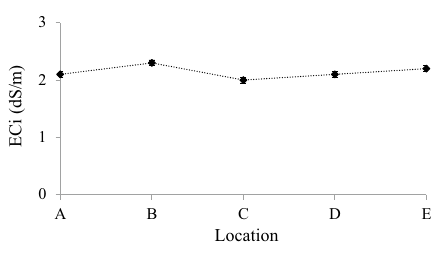
Fig. 1 Variation of irrigation water salinity measured at different locations at the